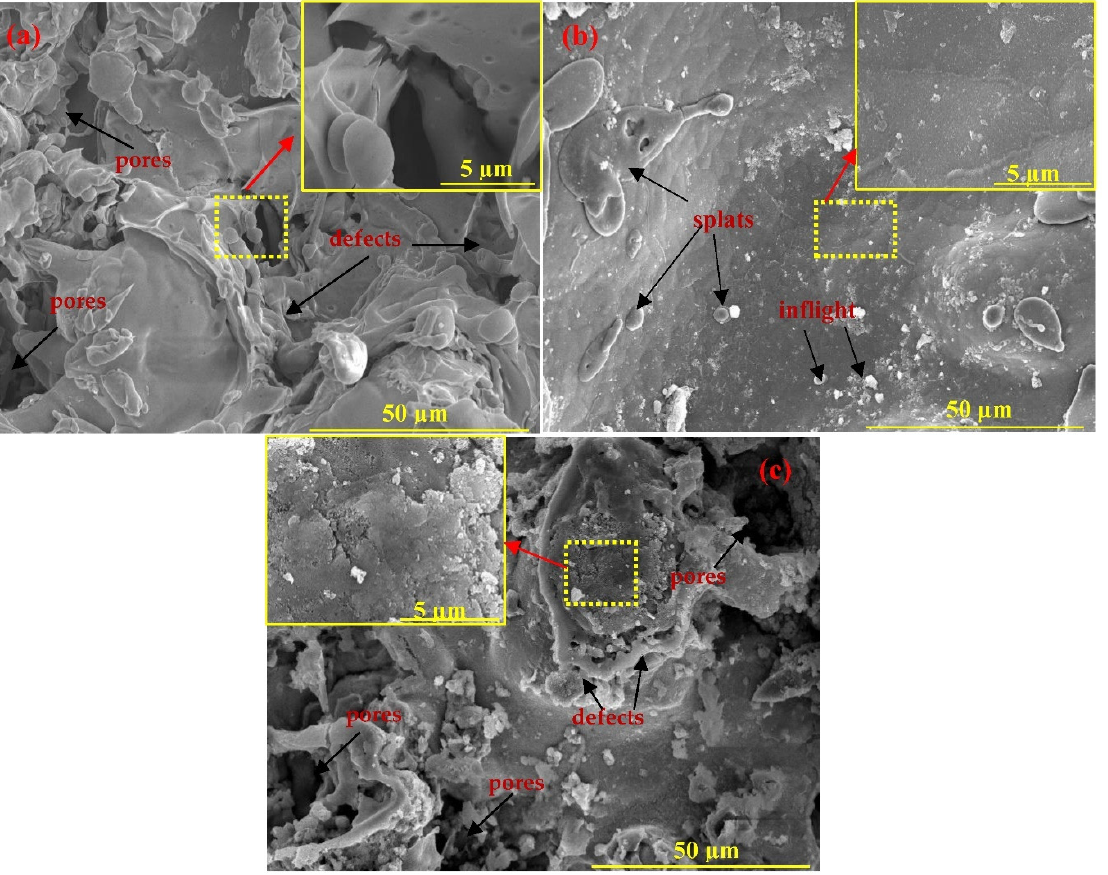
Figure 2. SEM of ( a ) Cu, ( b ) Ti, and ( c ) 85Zn-15Al coatings at 1000 × and 10,000 × (inset SEM images) deposited on the concrete